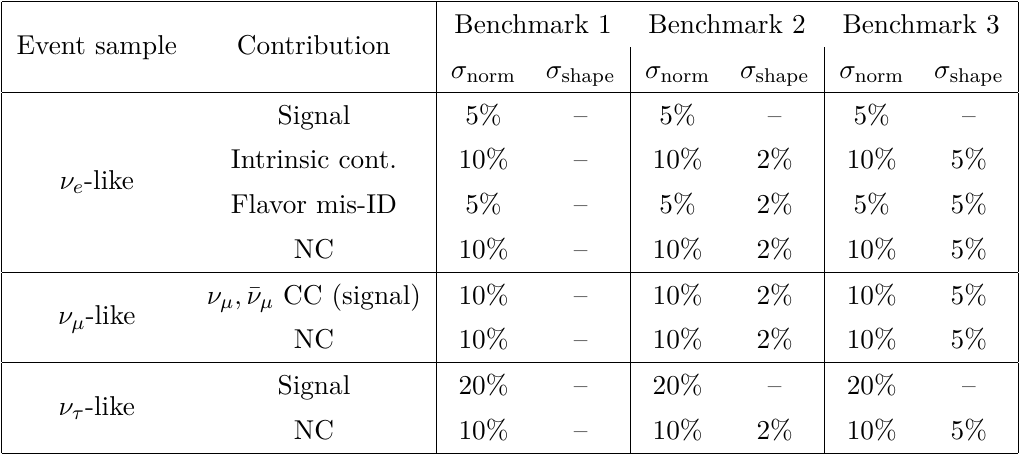
Table 3 . Assumed prior uncertainties affecting the normalization and shape of the event rates in our simulations, for the three benchmark scenarios considered in this work. We assume the same uncertainties (although completely uncorrelated) for the HE and nominal beam configurations, as well as for the neutrino and antineutrino modes. The background contributions are separated into intrinsic beam contamination (intrinsic cont.), flavor mis-identification (flavor mis-ID) and neutral- current (NC) backgrounds. We have numerically checked that for the ν e -like and ν τ -like events, including a shape uncertainty also for the signal has a completely negligible impact in the analysis, as expected. For additional details on the systematics implementation, see appendix